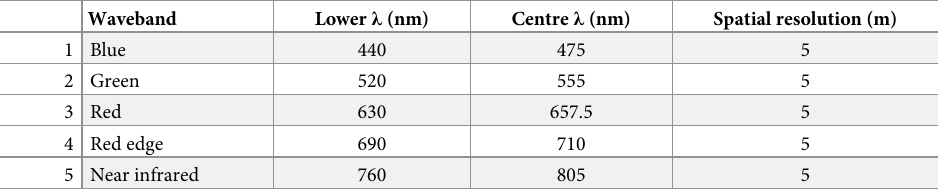
Table 2. RapidEye wavebands indicating the lower and centre wavelength with the specific resolution of each band. Waveband